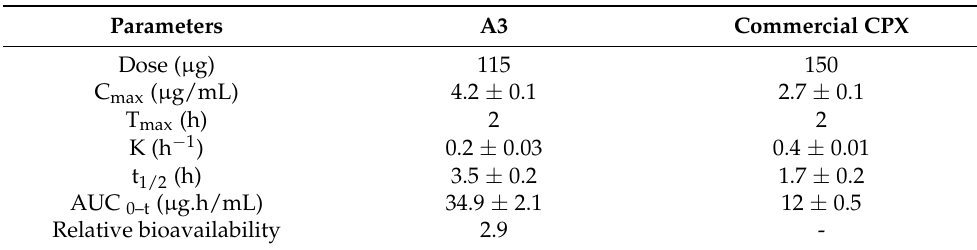
Table 2. Pharmacokinetics parameters of ophthalmic CPX- CLBF (A3) and commercial one (mean ± SD, n =